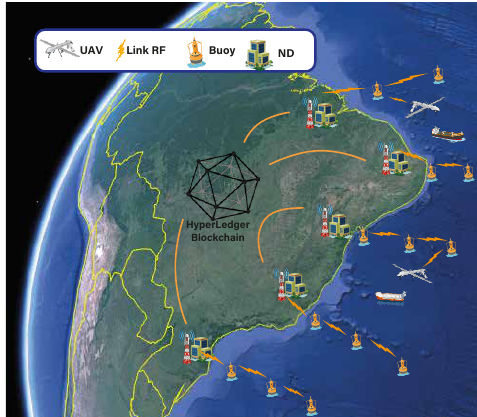
Figure 1. Blockchain-based